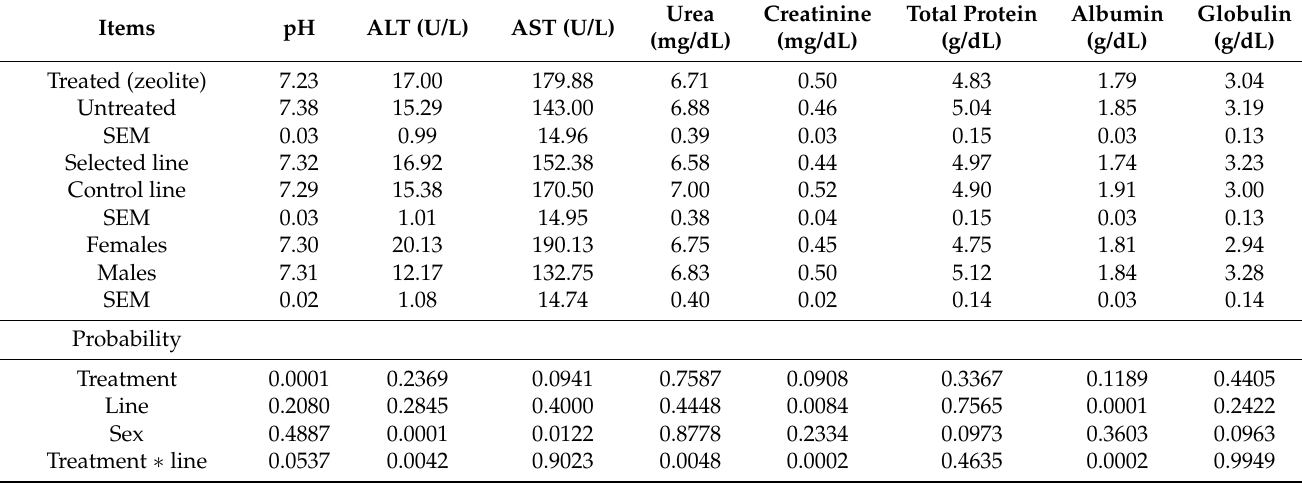
Table 5. Least square means for blood biochemical parameters as affected by treatment, line, and sex